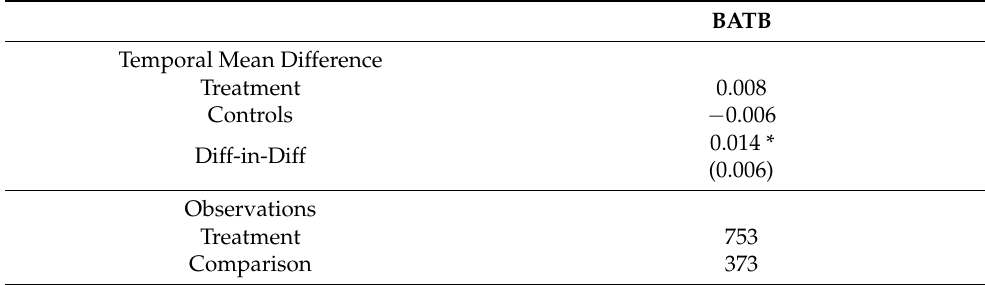
Table 2. Conditional DiD